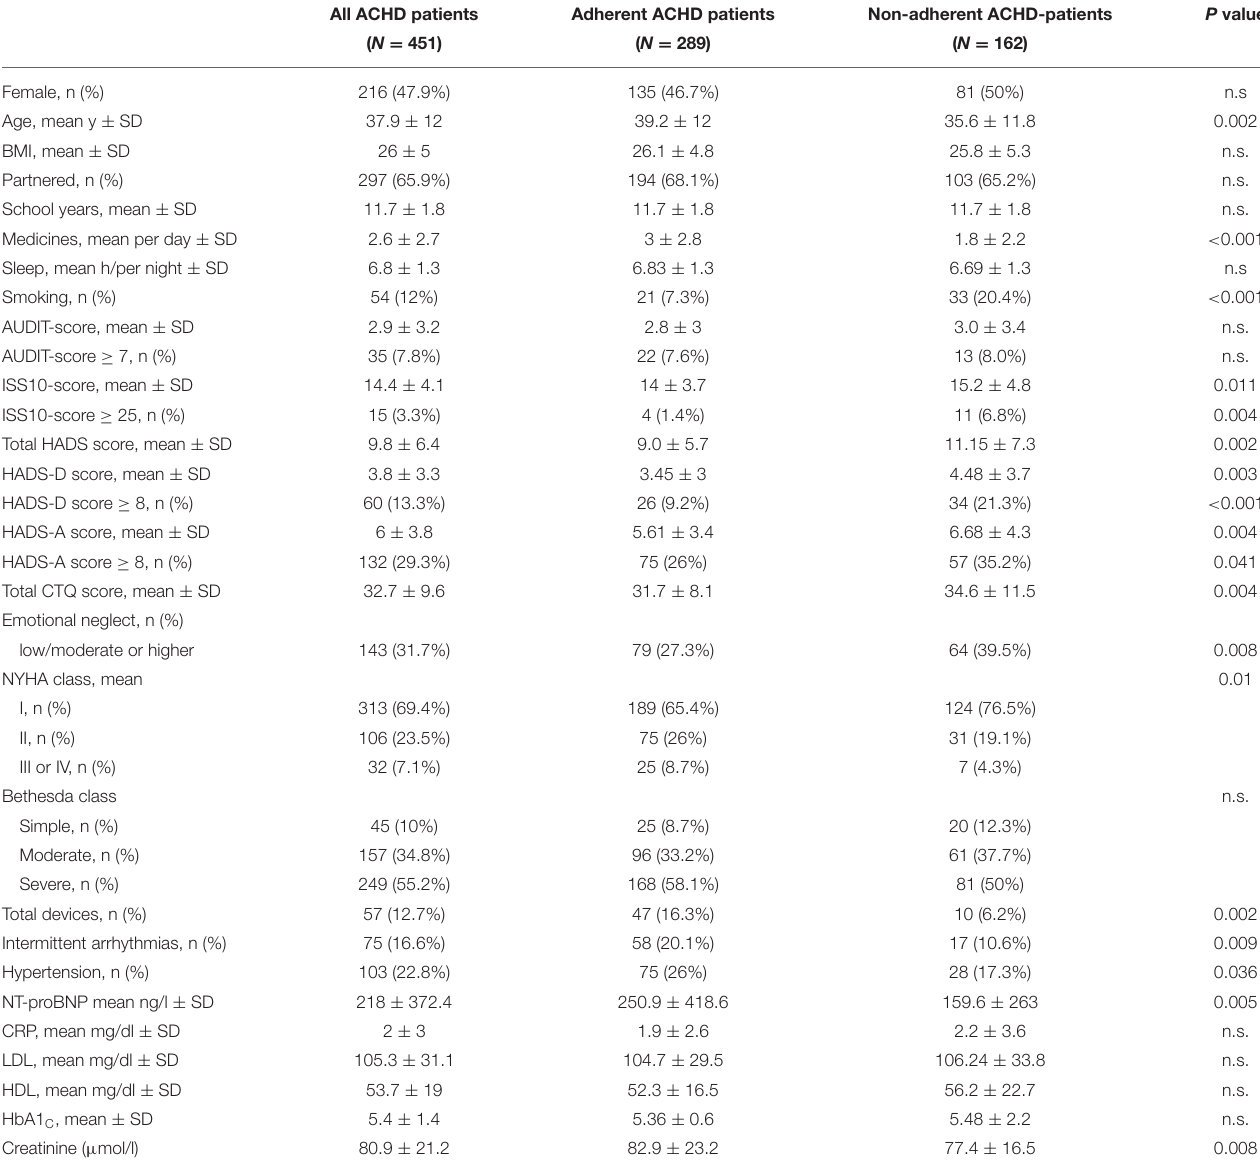
TABLE 1 | Demographic, lifestyle, psychiatric and cardiological data of adults with congenital heart disease (ACHD). All ACHD patients Adherent ACHD patients Non-adherent